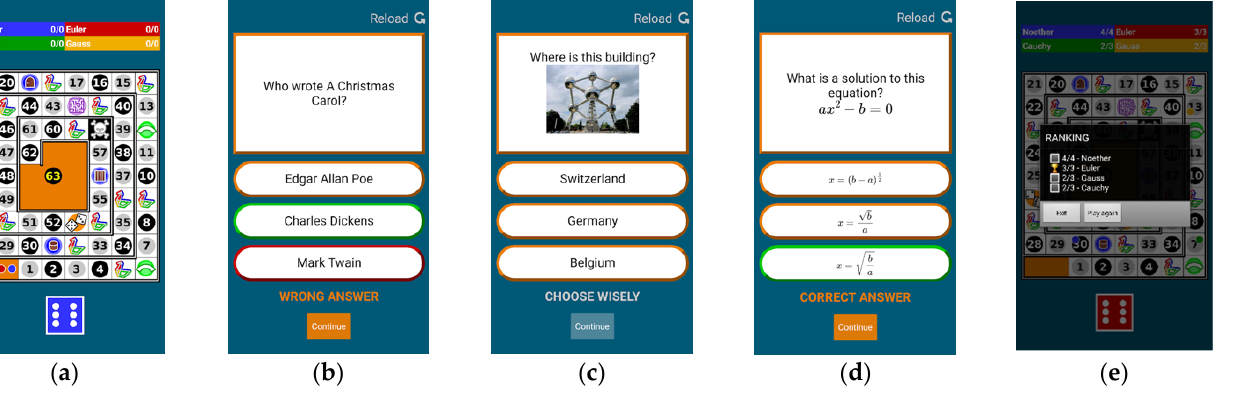
Figure 7. Interfaces in Cauchy App: ( a ) main interface; ( b ) example question with text only; ( c ) example question with an image in the statement; ( d ) example question based on formulas; and ( e ) ranking interface.